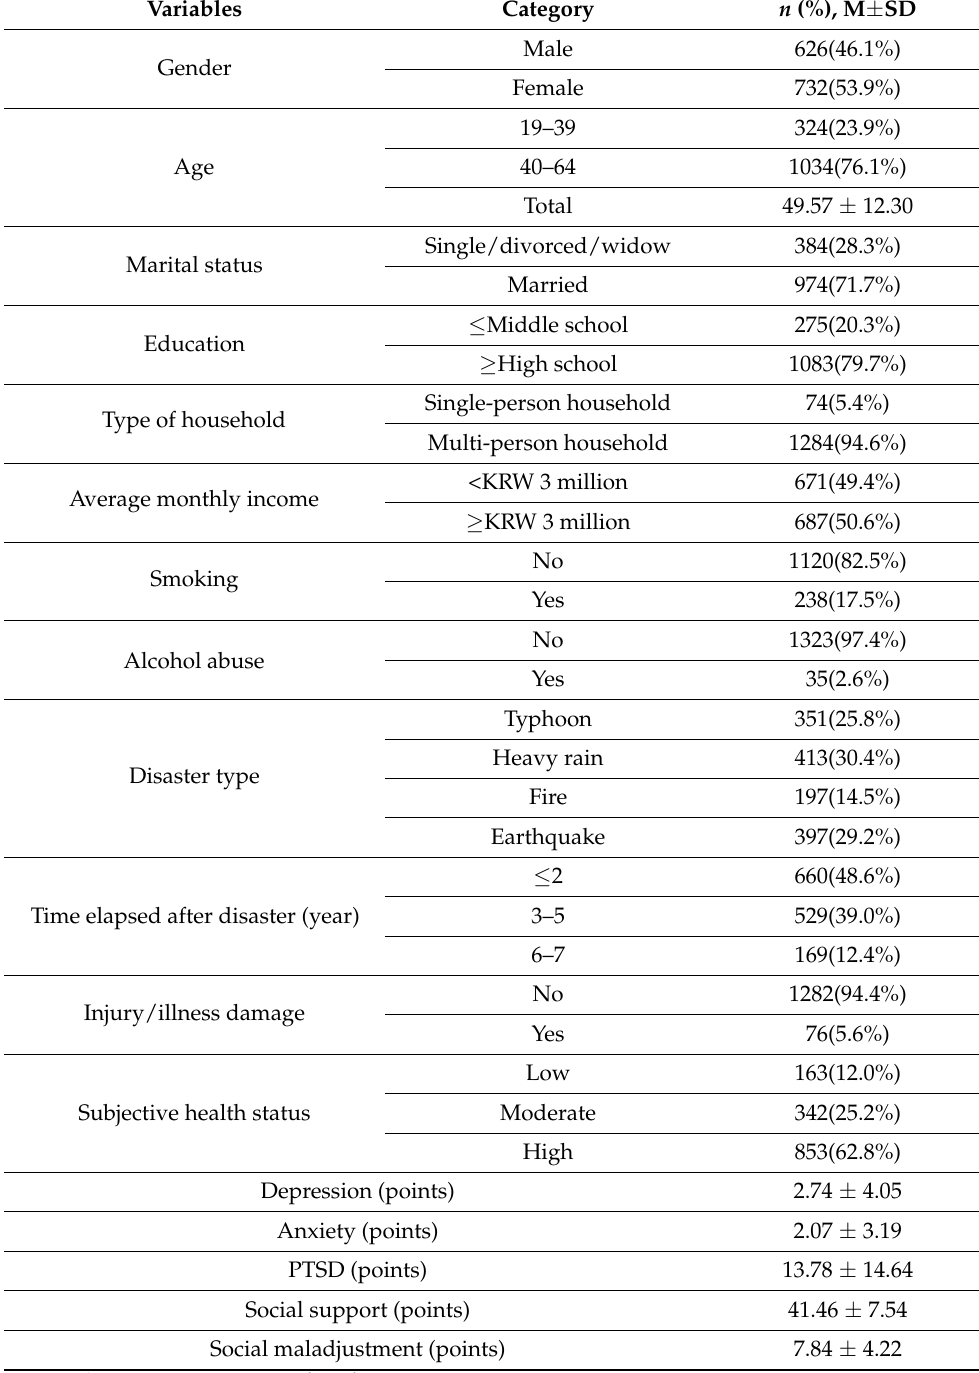
Table 1. Participants’ characteristics ( N =